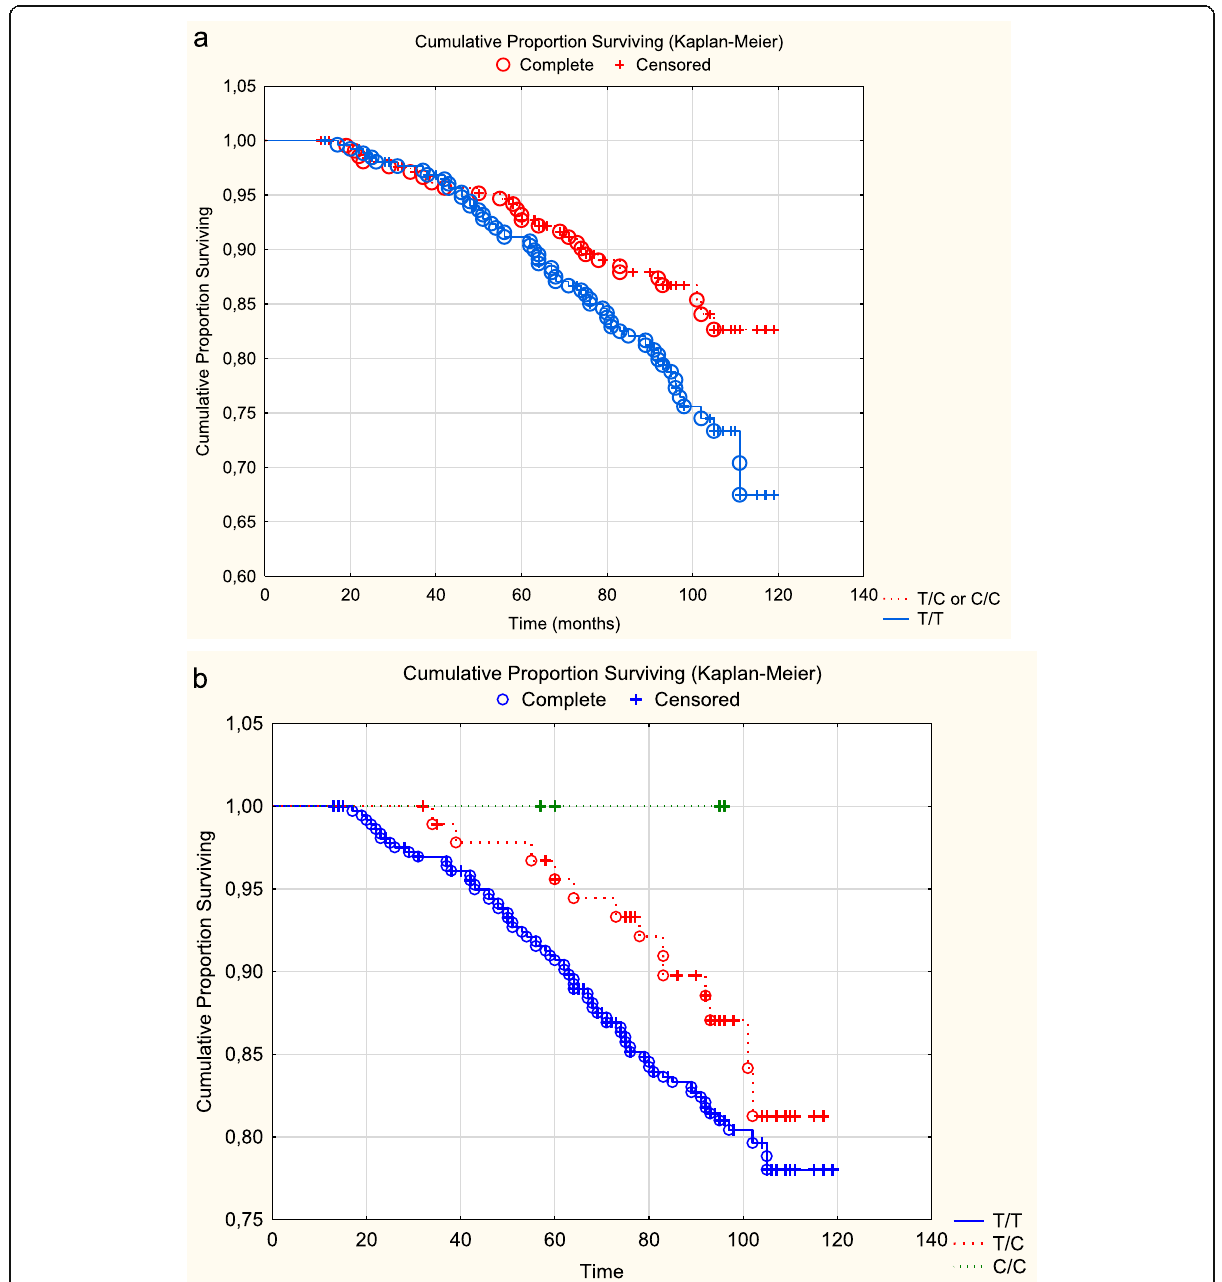
Fig. 3 a Cardiovascular mortality of the three genotypes of rs1478604 in the total study population during a follow-up time of 7.9 years. Note: Censored participants were those still living at the end of the study period, or who had died for reasons other than cardiovascular disease. Completed participants were those who had died due to cardiovascular disease. b . Cardiovascular mortality of the three genotypes of rs1478604 in the total female population during a follow-up time of 7.9 years. Note: Censored participants were those still living at the end of the study period, or who had died for reasons other than cardiovascular disease. Completed participants were those who had died due